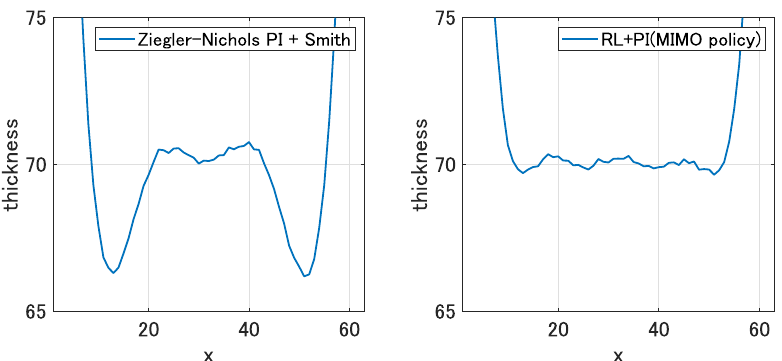
Figure 10. Film thickness distributions at the 500th step corresponding to the Ziegler–Nichols (Z.N.) PI controller and our proposed controller with spatial augmentation.